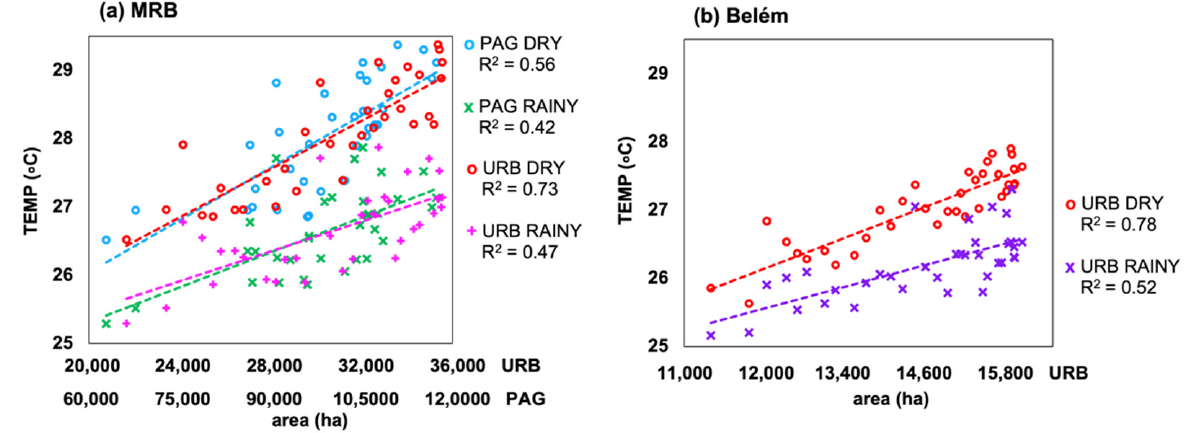
Figure 10. Scatterplots of ( a ) PAG and URB with TEMP for MRB; ( b ) URB with TEMP for Belém. Time series in the period 1985–2020.